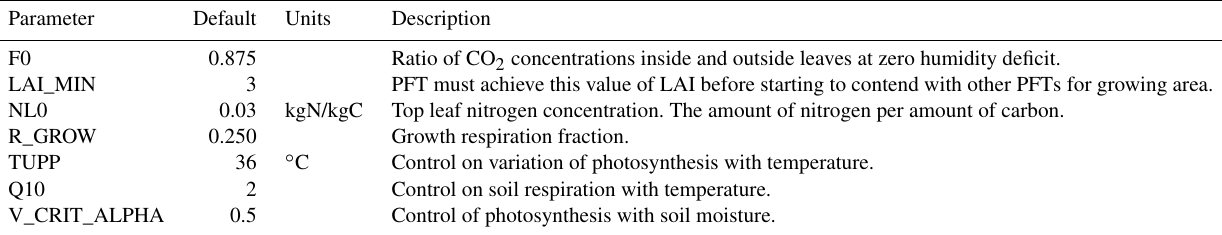
Table 1. Land surface input parameters for FAMOUS. PFT: plant functional type; LAI: leaf area index.